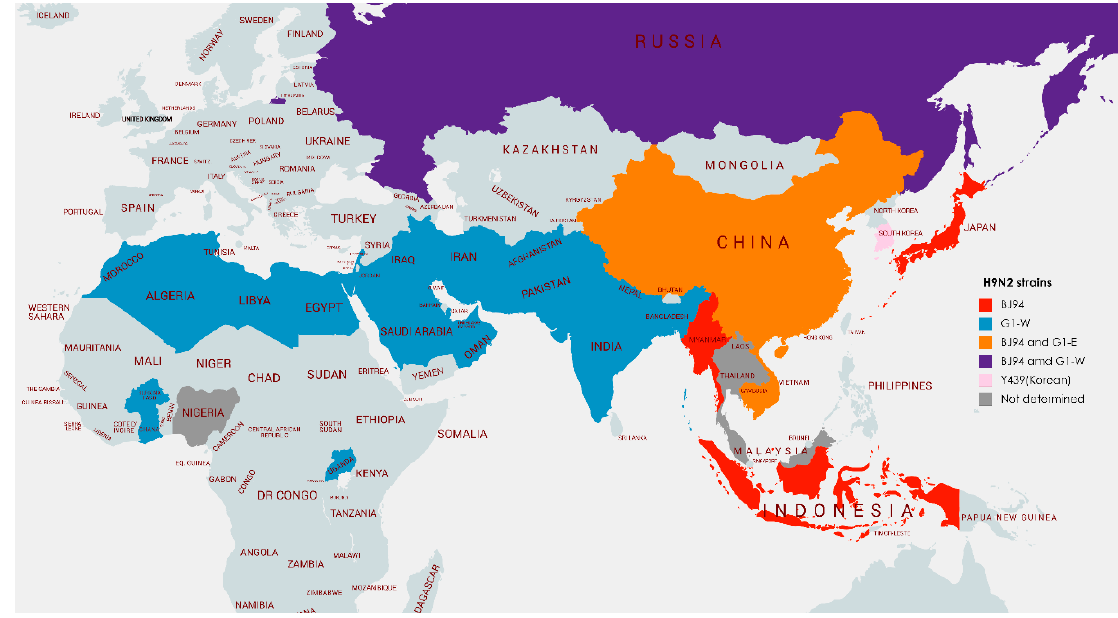
Figure 1. Phylogeographic range of poultry-adapted H9N2 lineages. Countries where only BJ94 lineage viruses are found shown in red, where only G1-W viruses found shown in blue, where mixtures of BJ94 and G1-E sub-lineage viruses are found shown in orange, where mixtures of BJ94 and G1-W sub-lineage viruses are found shown in purple, where only poultry-adapted Y439-lineage viruses are found shown in light pink. H9N2-positive countries where H9N2 lineage hasn’t been determined shown in grey. Figure made using mapchart.net.